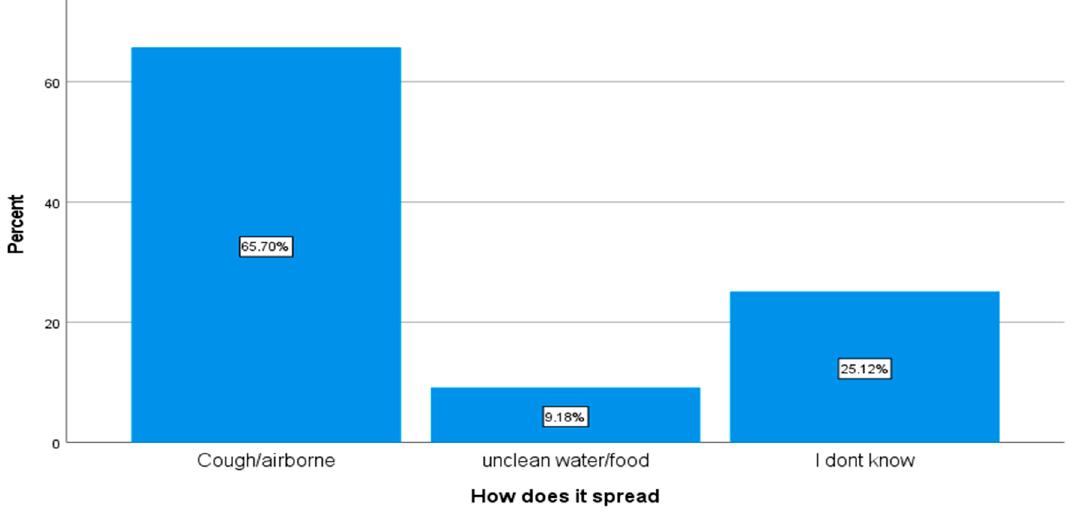
Figure 2. Knowledge about transmission of TB ( n = 207).